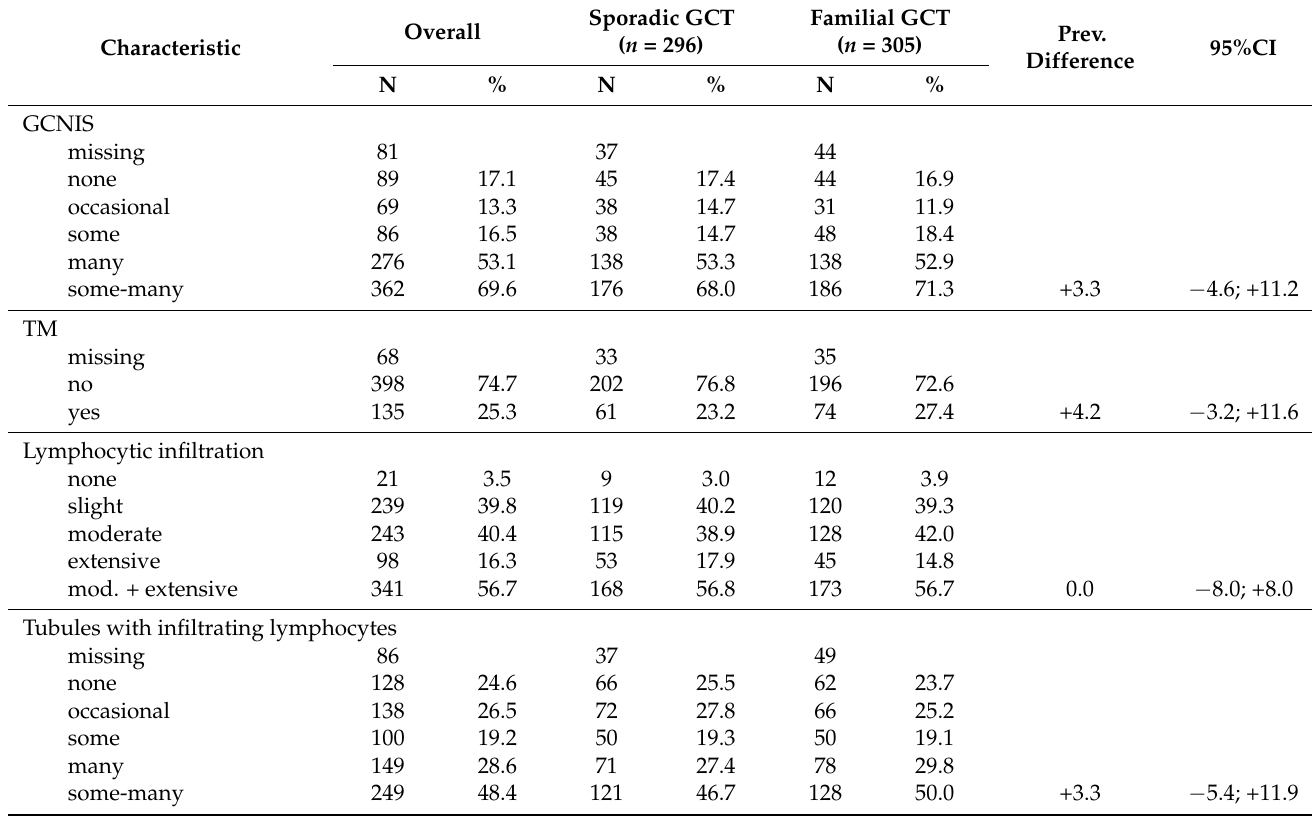
Table 2. Germ cell neoplasia in situ (GCNIS), testicular microlithiasis (TM), lymphocytic infiltration and tubules with infiltrating lymphocytes among sporadic and familial testicular germ cell